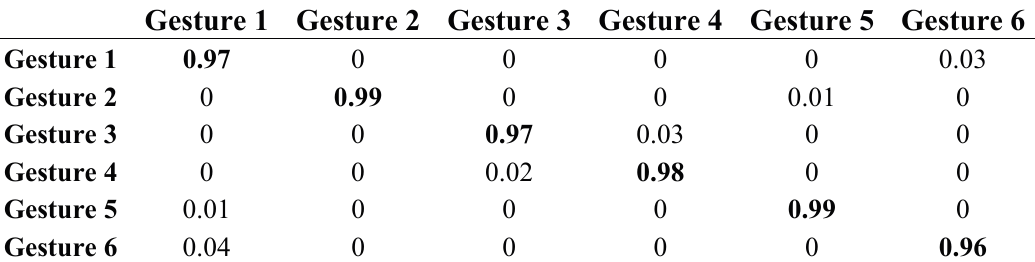
Table 1. Confusion matrix of target